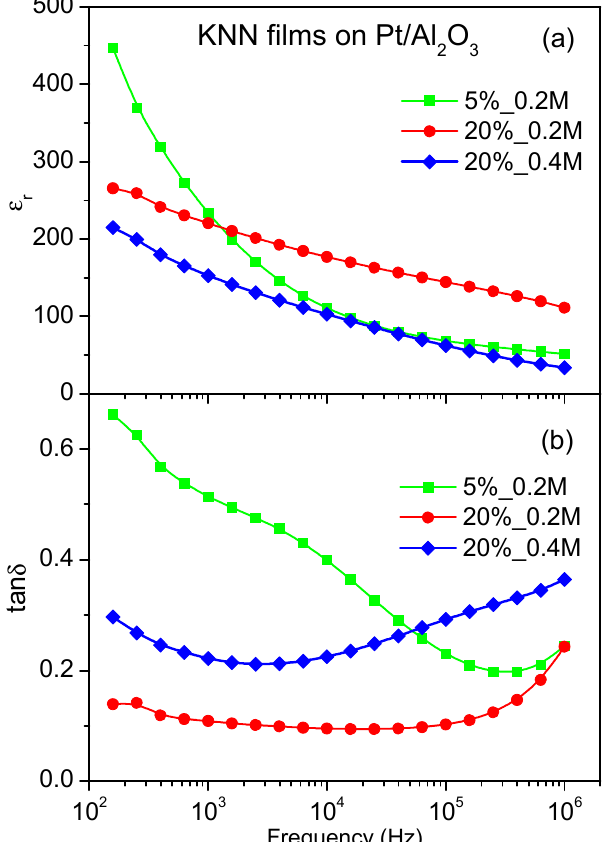
Figure 4. Room temperature relative permittivity ε r (( a ), solid symbols) and dissipation factor tan δ (( b ), open symbols) as a function of frequency for KNN thin films deposited on platinized Al 2 O 3 from solutions with 5% potassium excess and 0.2 M concentration (squares), with 20% alkali excess and 0.2 M concentration (circles), and with 20% alkali excess and 0.4 M concentration (rhombs).